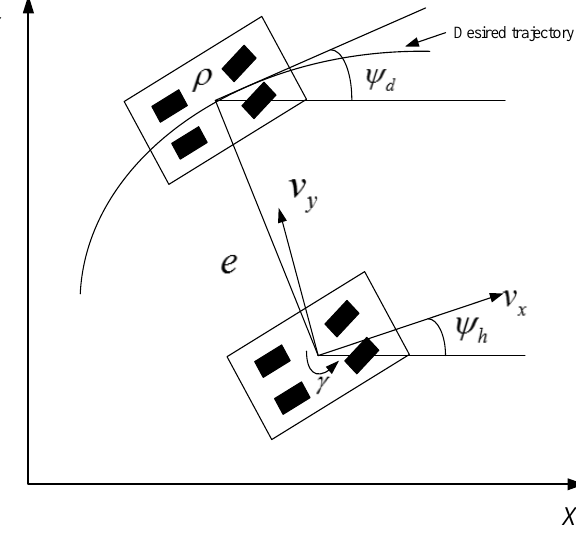
Figure 3. Vehicle trajectory tracking model.